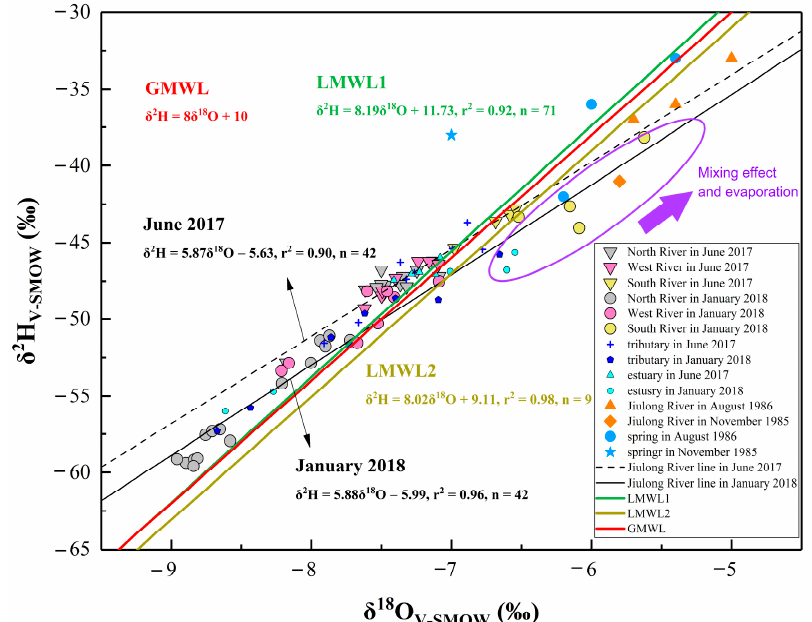
Figure 2. Correlations between δ 18 O and δ 2 H in the Jiulong River water. The δ 18 O and δ 2 H of river water and spring which were sampled in August 1986 and November 1985 were quoted from reference [36]. GMWL: Global Meteoric Water Line [35]. LMWL1: Meteoric Water Line of Fuzhou [33]. LMWL2: Meteoric Water Line of Zhangzhou [36].